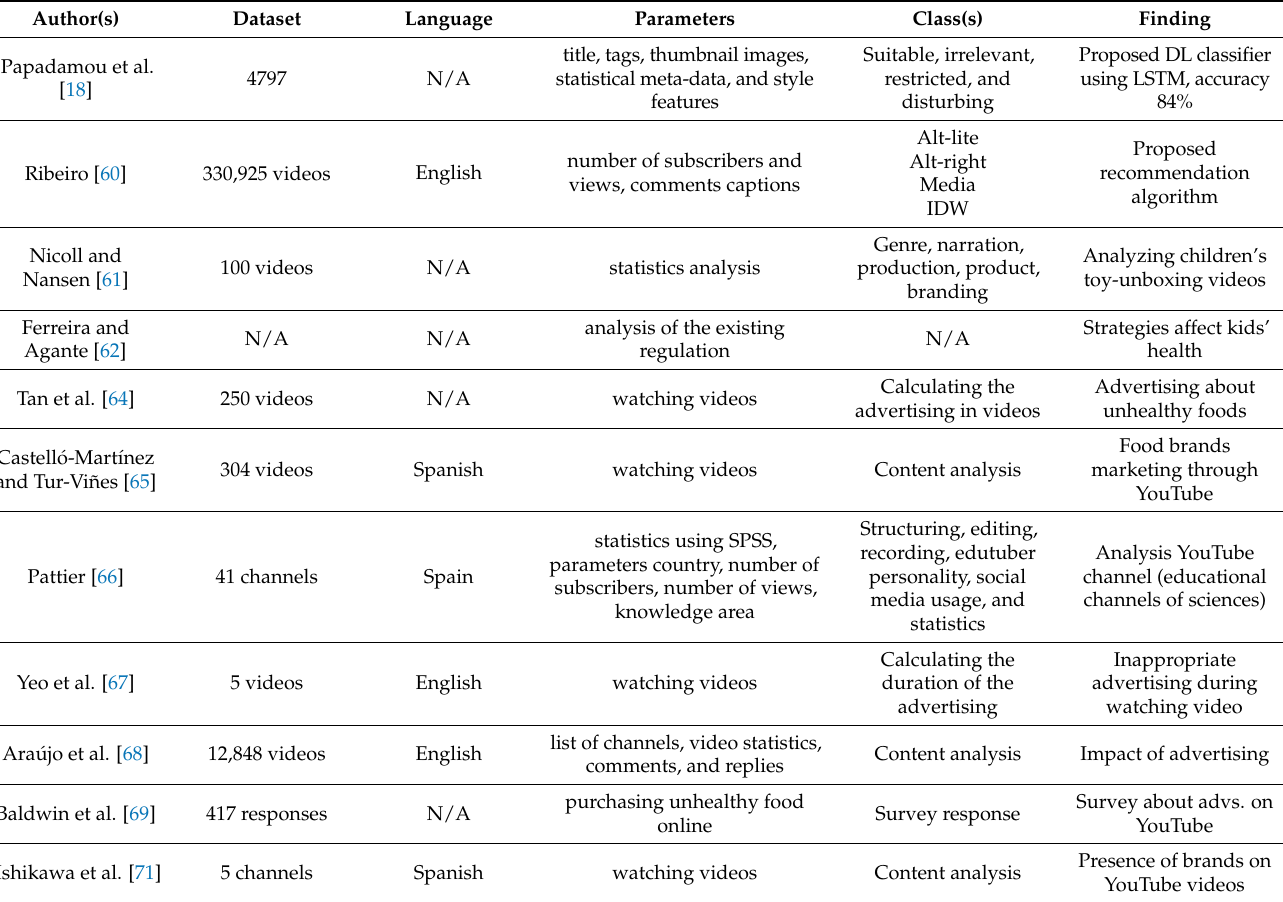
Table 3. Comparative study on meta-data